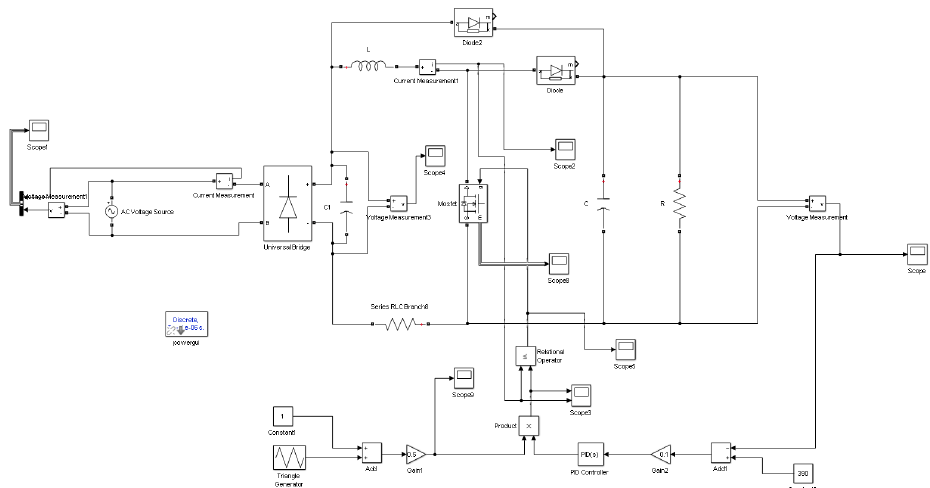
Figure 9. The simulation model of PFC. The simulation results of the input voltage and current are shown in Figure 10. It can be seen from Figure 10a that the impedance angle ϕ (phase difference between the input voltage and current) is large and the power factor cos ϕ is small; Figure 10b shows that the input voltage and current phase are consistent and the power factor can reach more than 99%.